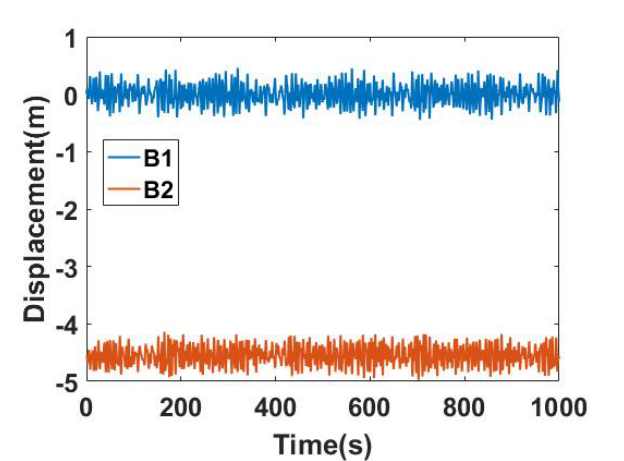
Fig. 9: The displacement of the first and the second mass measured from the mean water level to the center of gravity of the two bodies.